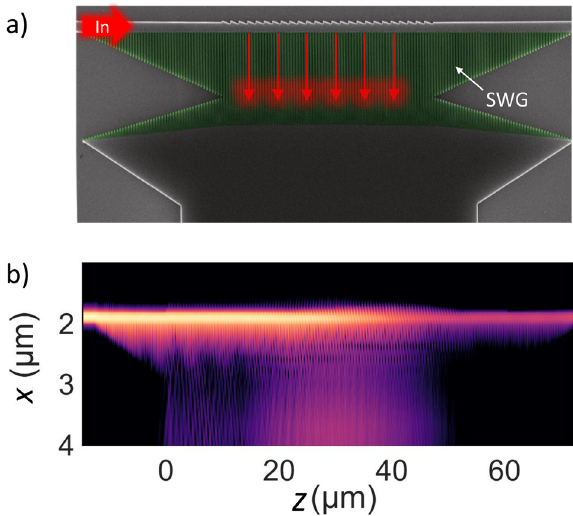
Figure 12: (a) SEM image of a fabricated sidewall grating deflector. The red arrows indicate the deflected light propagation direction and the green region comprises the SWG. (b) Field propagation inside the deflector. The light entering from the left gets progressivelydiffractedtowardsthewidewaveguideasacollimated Gaussian